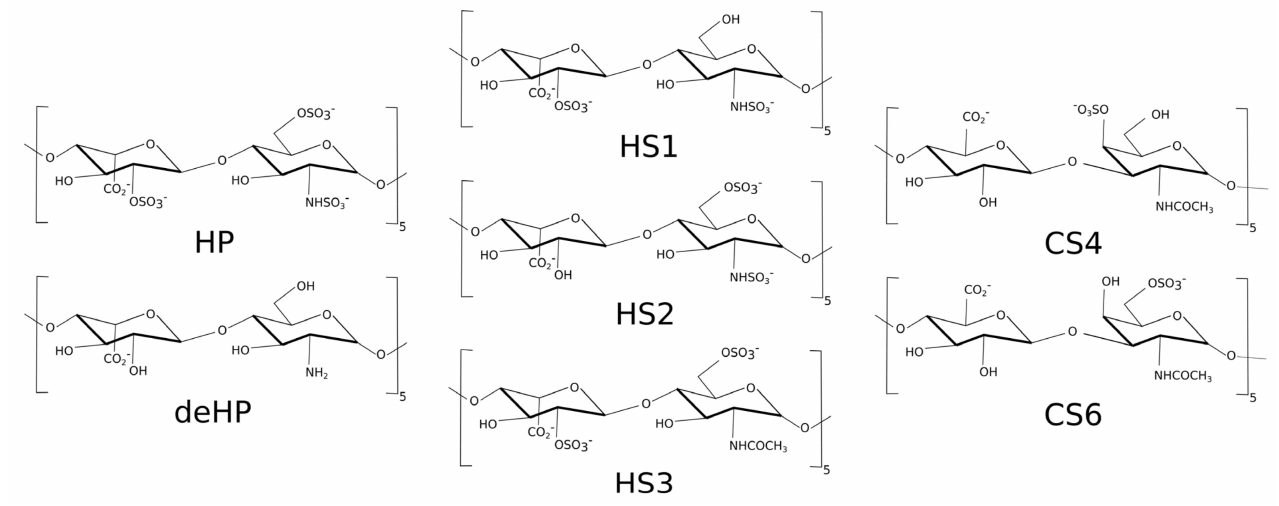
Figure 2. Three heparan sulfate (HS) dp10 structures used in this